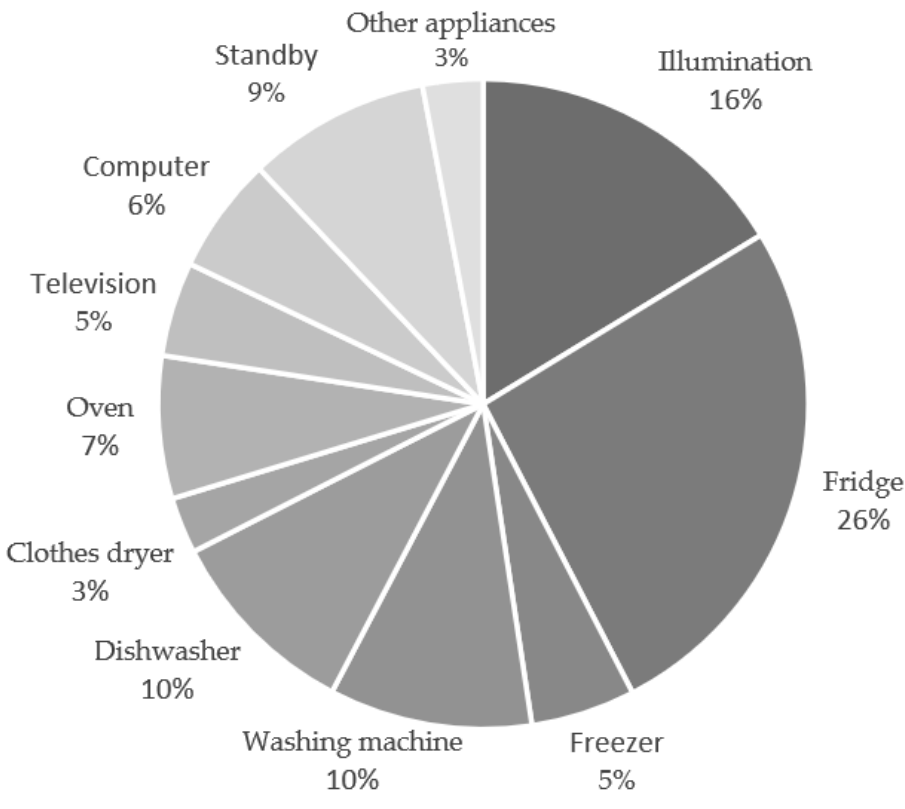
Figure 12. Typical annual share of household device consumption. Table 2. Efficiency comparison of the different scenarios respect to the current one, evaluating the impact of EVs on them, all units in